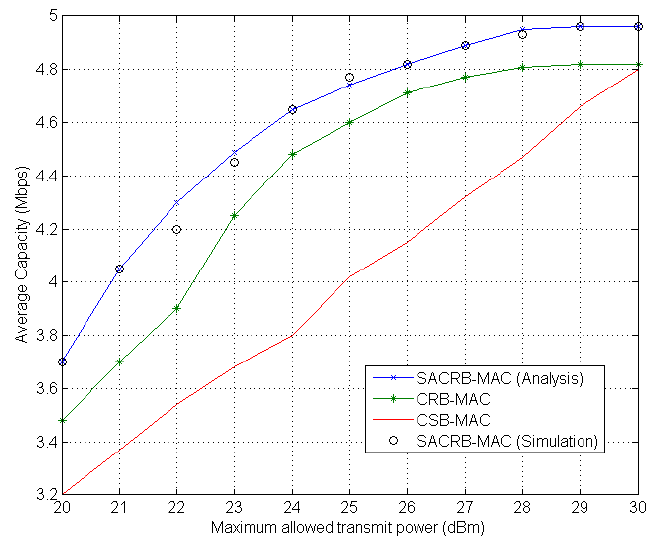
Figure 7. Average capacity performance against the maximum allowed transmit power of each